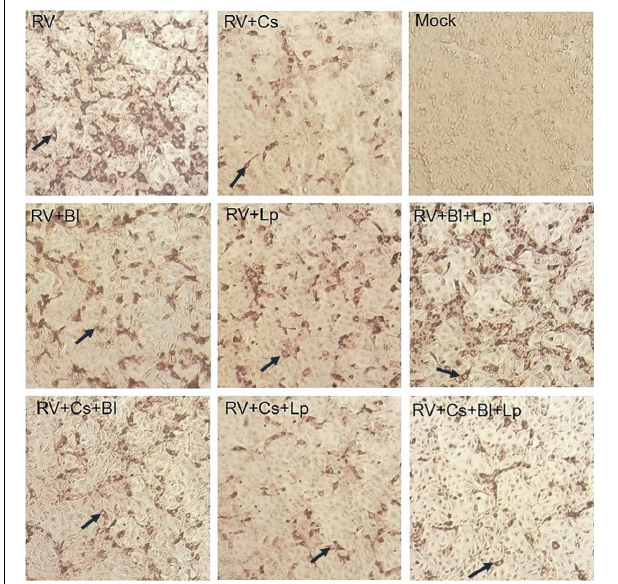
FIGURE 3 | Rotavirus focus forming units in HT-29 cells treated with combination of probiotics and/or Chlorella sorokiniana. RV, Rotavirus; Bl, Bifidobacterium longum ; Lp, Lactobacillus plantarum; Cs, Chlorella sorokiniana. Arrows indicate units forming focus in each